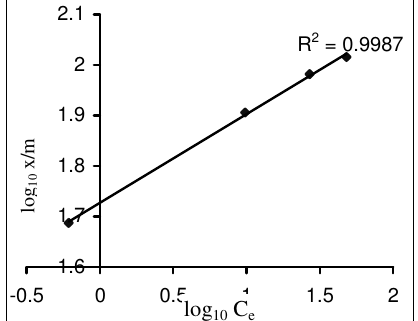
Figure 6 . Freundlich plot for crystal violet